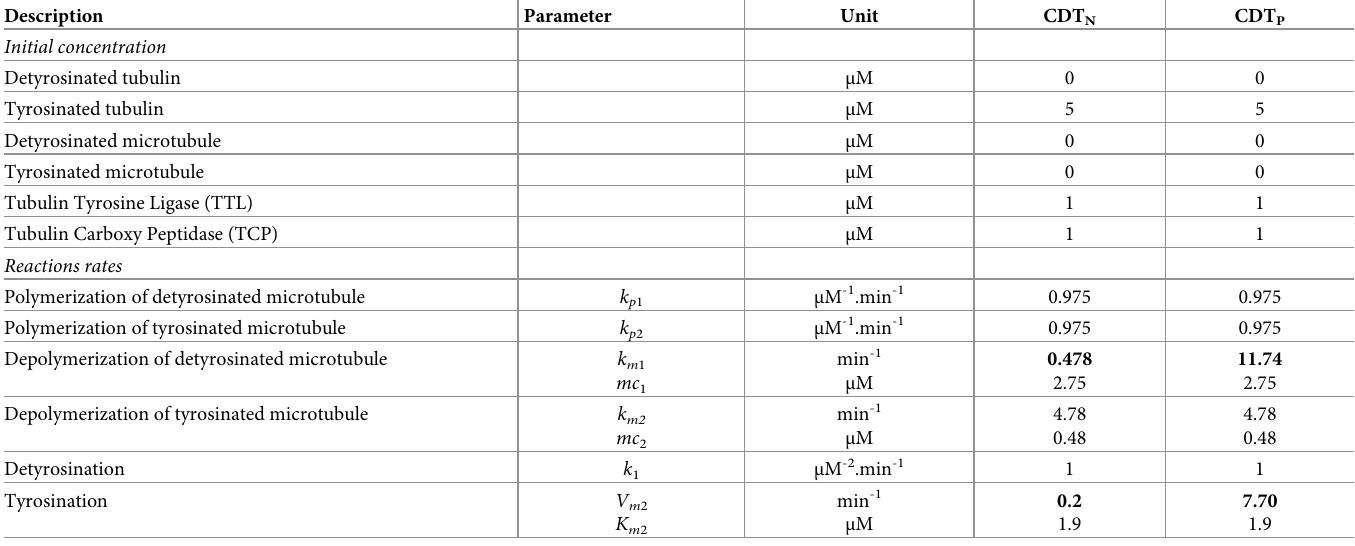
Table 1. Parameter values of the computational